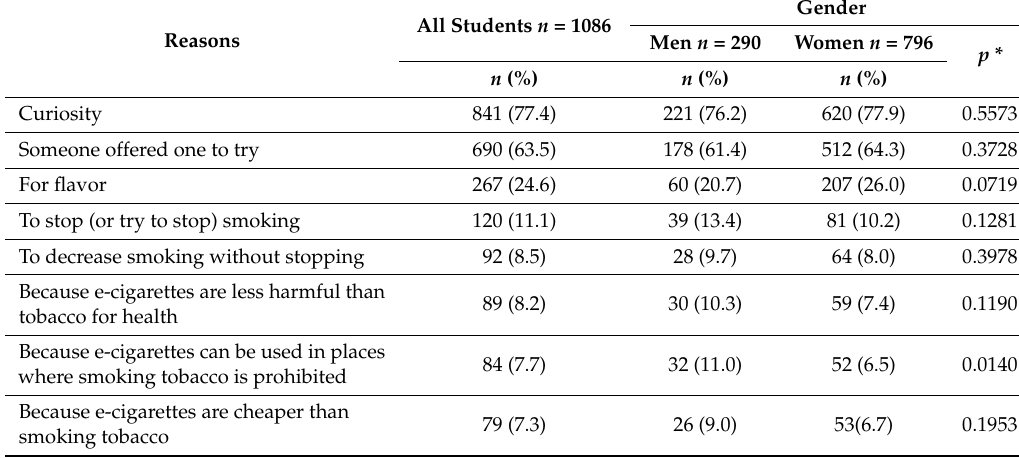
Table 4. Reasons for trying e-cigarette (overall and according to gender) among students who had tried it.